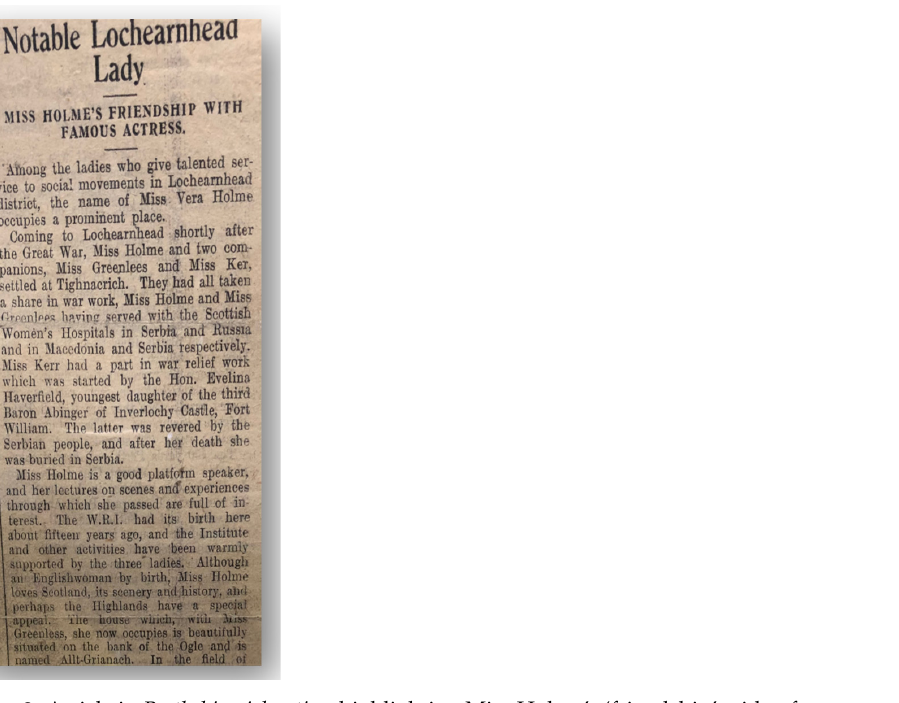
Figure 3. Article in Perthshire Advertiser highlighting Miss Holme’s ‘friendship’ with a famous ac- tress of the time, 1938, Vera Holme Papers, Women’s Library, LSE,